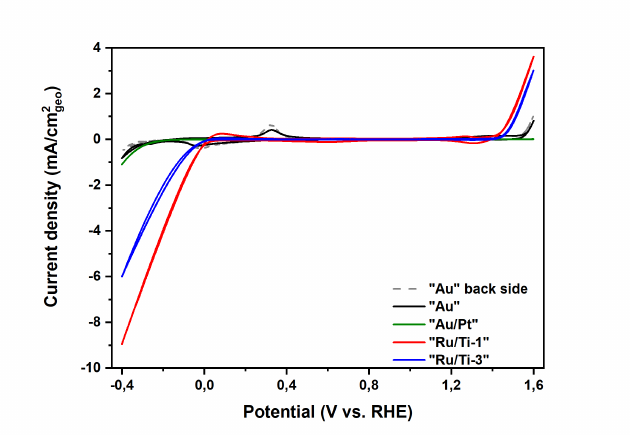
Figure 21. Cyclic voltammograms of all investigated samples obtained at a scan rate of 20 mV/s in Ar saturated 0.1 M